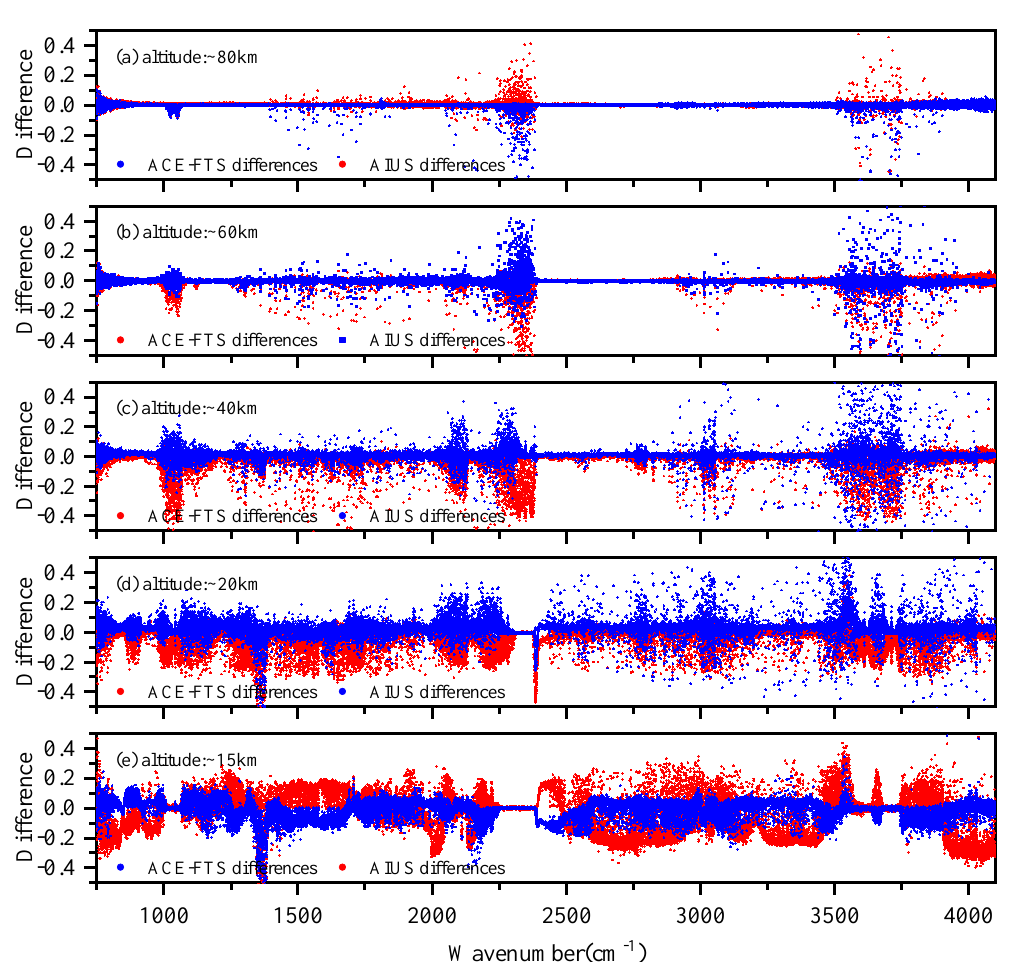
Figure 4. The transmittance differences between AIUS/ACE-FTS and simulated